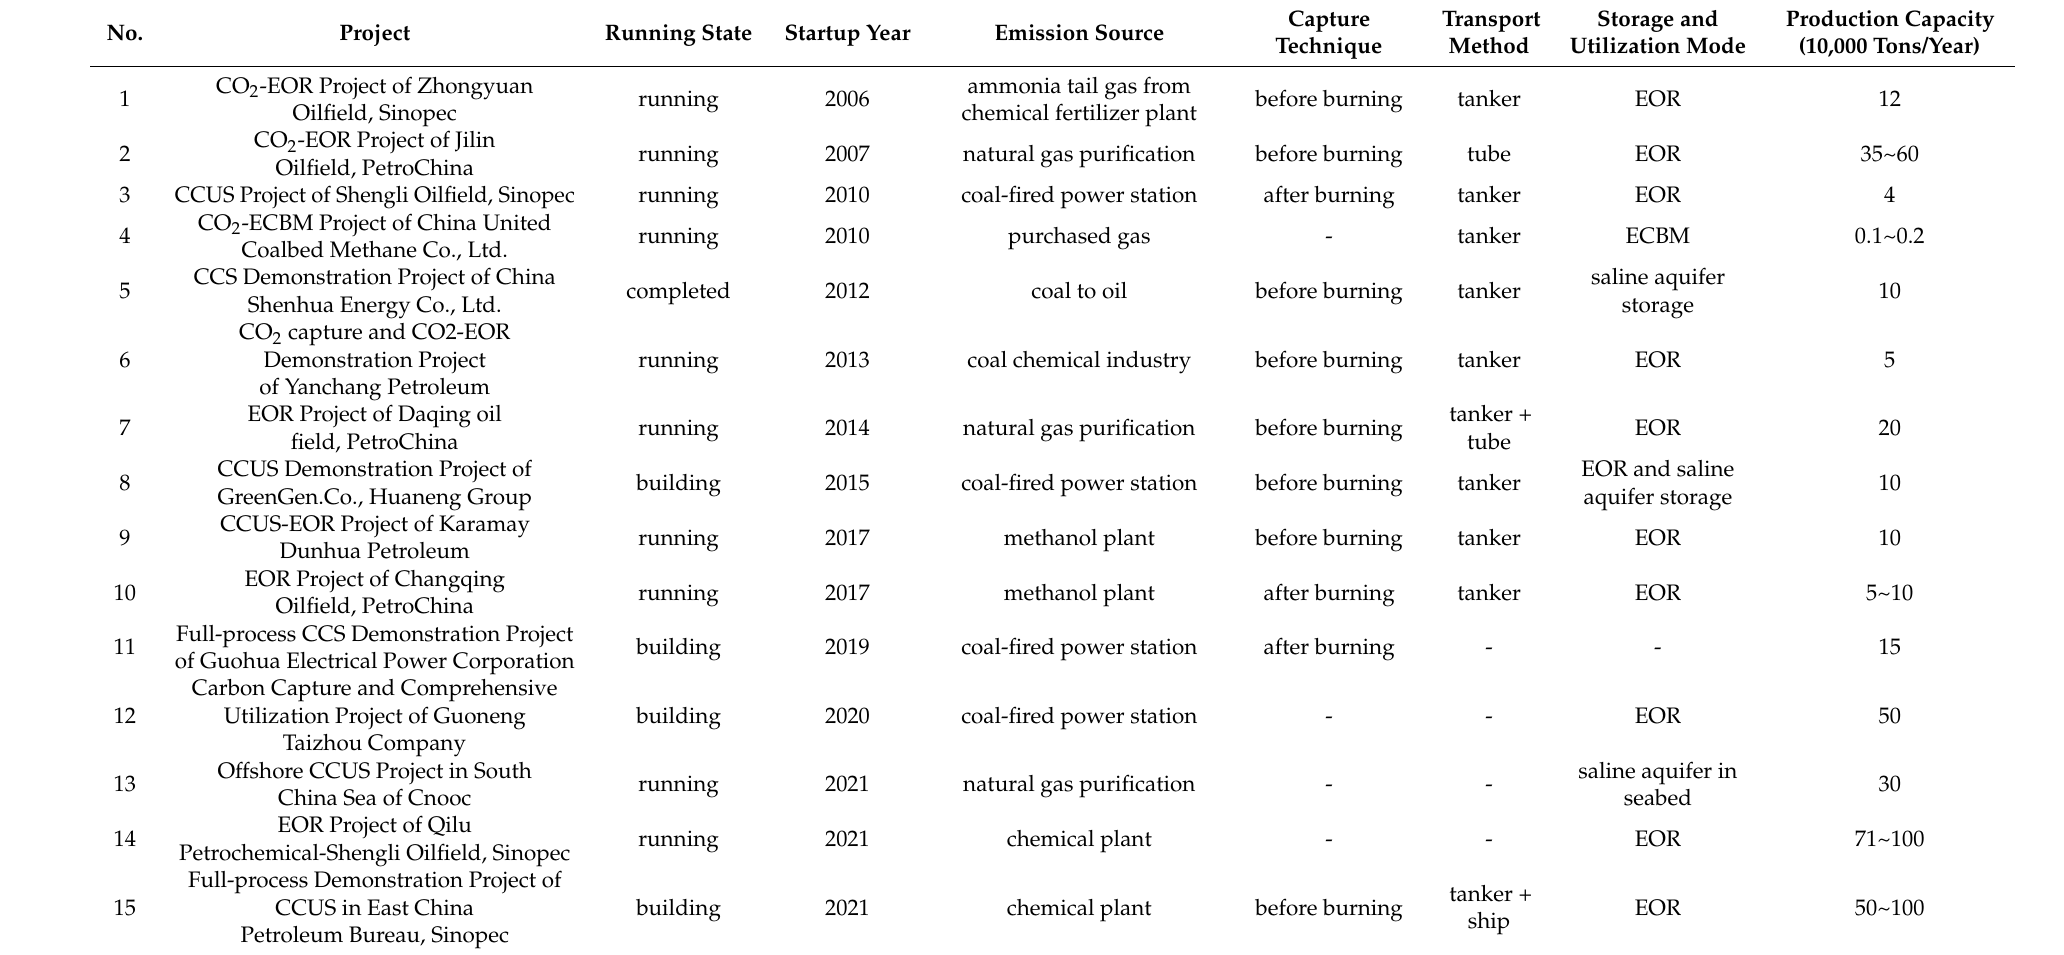
Table 4. Major CCUS full-process projects in China